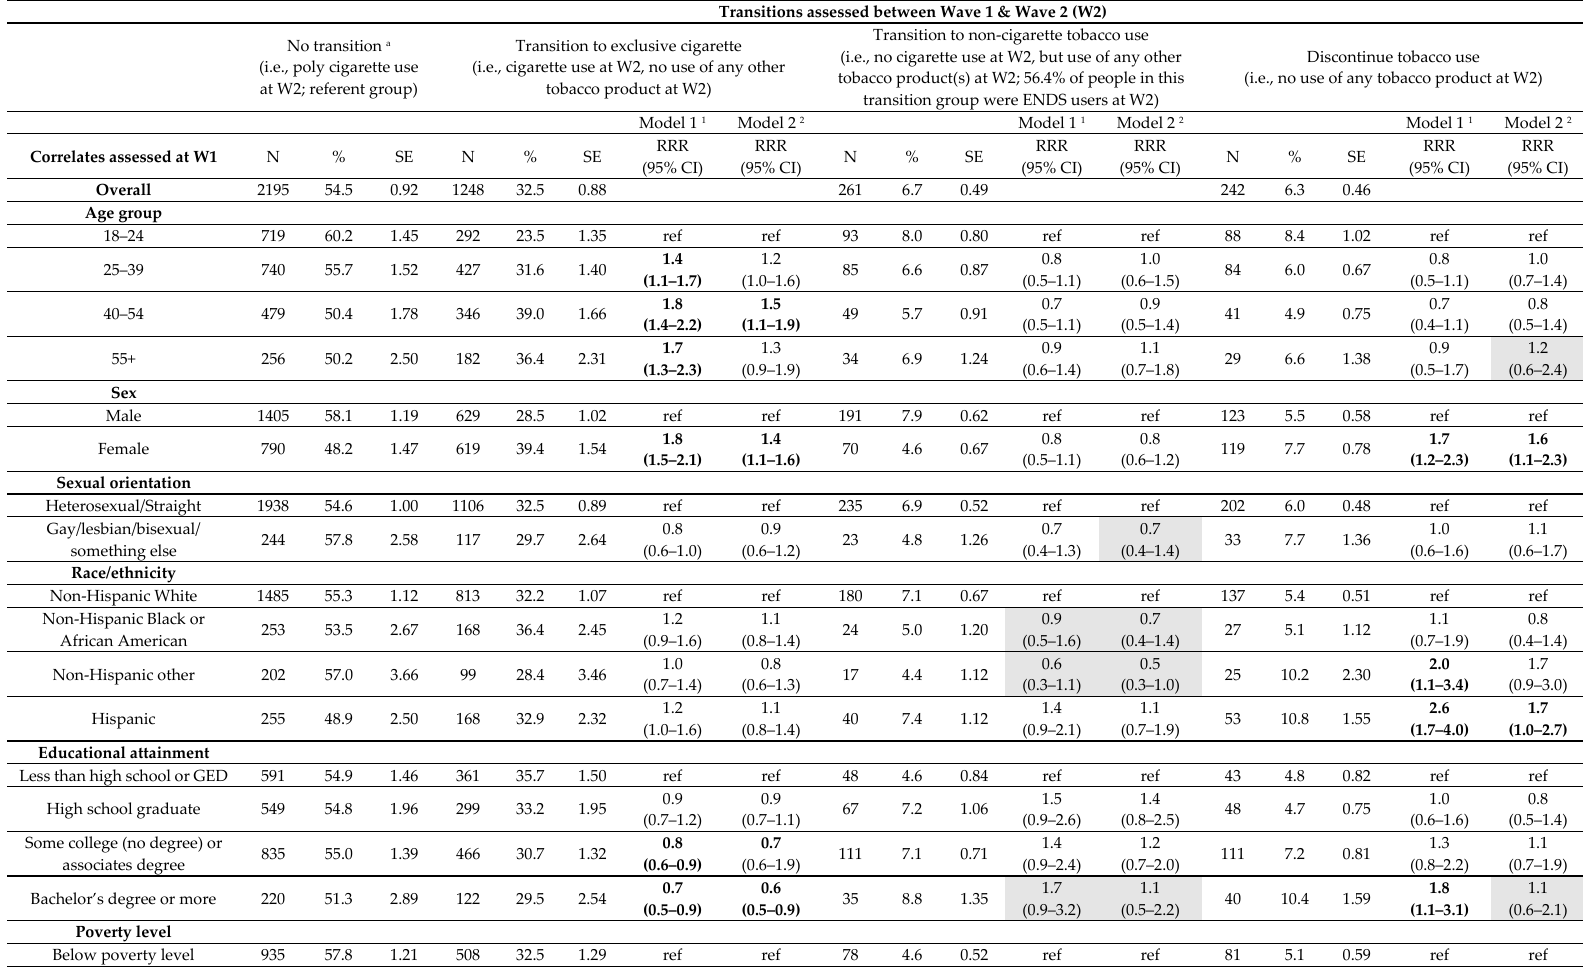
Table 4. Correlates of transitions in tobacco product use among ‘poly cigarette’ smokers at Wave 1 (W1) ⱡ. No transition a (i.e., poly cigarette use